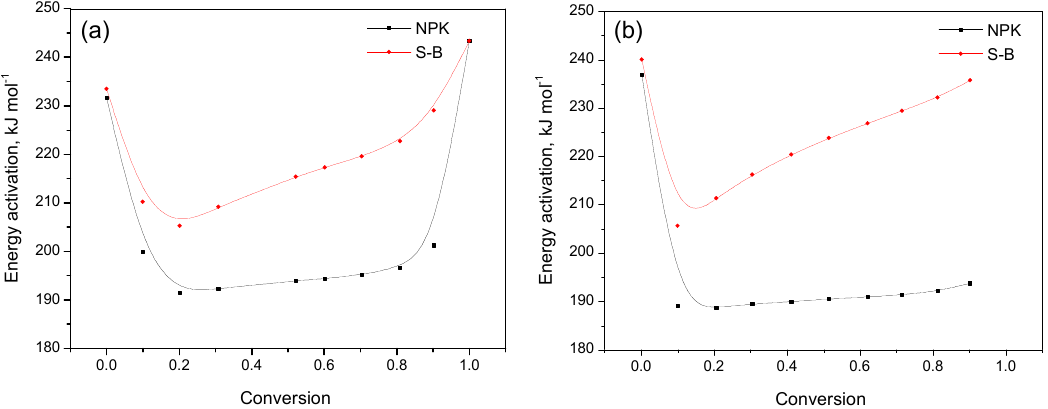
Figure 9. Activation energy ( E ) dependence on conversion rate ( α ) for p-PGFPh:AA copolymers at initial ratios М 1 :М 2 , mol.%: ( a )−6.77:93.23 and ( b )−86.67:13.33.